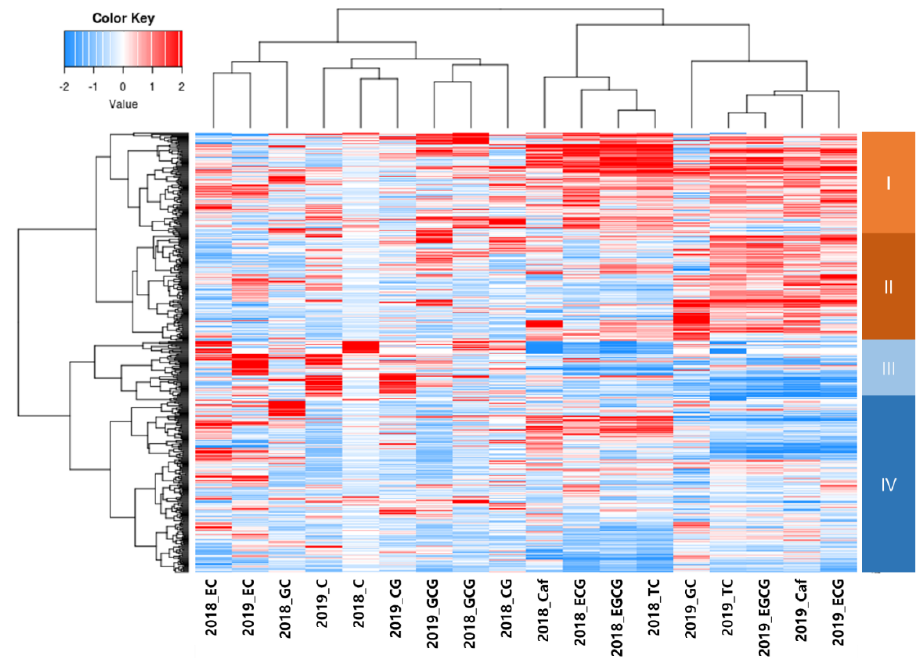
Figure 1. Hierarchical clustering analysis of the phytochemicals in the 462 tea accessions. The colours in the heatmap indicate the z-score which was calculated by subtracting the mean of phytochemicals across different samples and dividing it by the standard deviation of the phytochemicals across all the samples. The red color indicates positive z-score, the white color indicates zero z-score, whereas the blue colour indicates negative z-score. Higher intensity of the color in the scale indicates a higher magnitude of the z-score. The dendrogram on the x-axis indicates the degree of similarity between the phytochemicals, the closer the phytochemicals the higher the level of similarity in them and the phytochemicals have been clustered using hierarchical clustering. Similarly, the dendrogram on the y-axis indicates the degree of similarity between the different samples, the closer the samples the higher the level of similarity in them and they have been clustered using hierarchical clustering (Ward, Euclidean distance). Table 2. Average cluster values of the phytochemicals in the 462 tea accessions for the two years (mg/g).